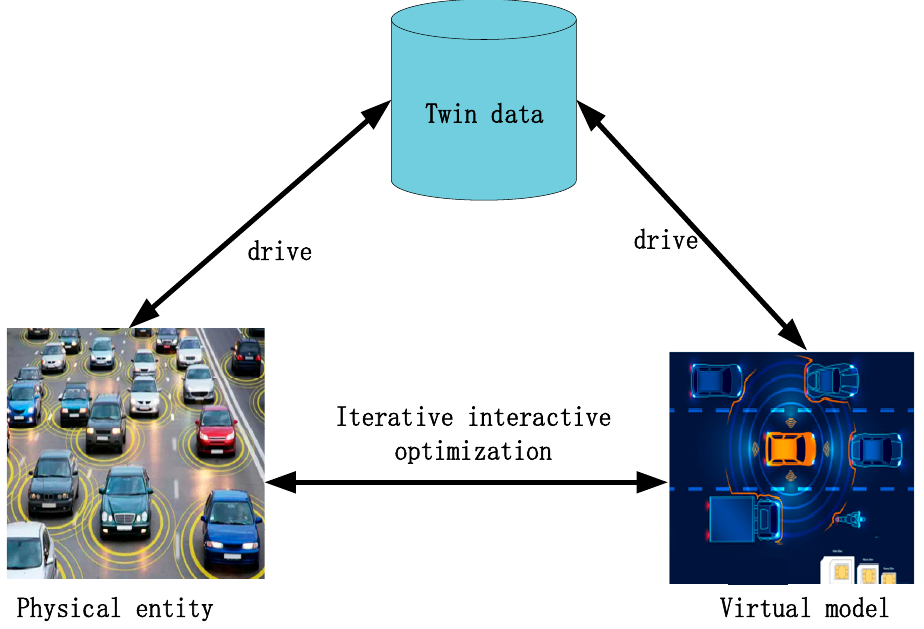
Figure 2. Vehicular networking architecture diagram.